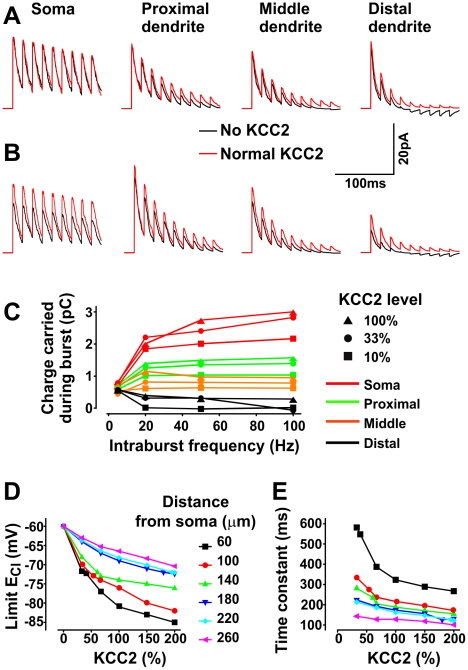
Dependency of Cl− accumulation on the site of synaptic input and KCC2 level.Trains (40 Hz) of inhibitory postsynaptic currents (IPSCs) at a synapse located at one of four positions: soma and proximal, middle, and distal dendrites (40, 100, and 240 µm from soma, respectively) in simulations without (A) and with (B) background synaptic input (f
inh  =  0.4 Hz, f
exc  =  0.1 Hz). For this set of simulations, a single dendrite was lengthened (and number of compartments increased to 60) relative to the cell geometry summarized in Fig. 1A. Inversion of the IPSC was evident in the distal dendrites under conditions without KCC2 (right panels). C. Mean intraburst IPSC became smaller (i.e. less hyperpolarizing) with increasing distance from the soma and with decreasing KCC2 level. Synaptic background activity was the same as in B. Mean IPSC was measured at a “test” synapse activated at 40 Hz for 200 ms every second over 50 s of simulated time. Steady state value of E
Cl (D) and rate at which E
Cl approaches steady state (E) for different KCC2 levels and distances of “test” synapse from the soma. Steady state E
Cl reported in D was measured as the value to which E
Cl converged when GABAAR at the test synapse were artificially held open. This convergence was fit with a single exponential to determine the time constant reported in E.